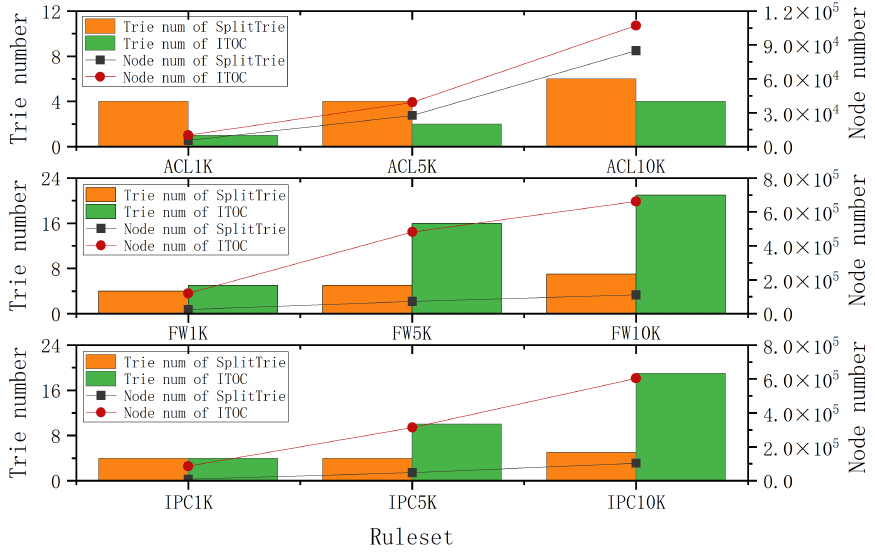
Figure 7. The memory footprint comparison between SplitTrie and ITOC.